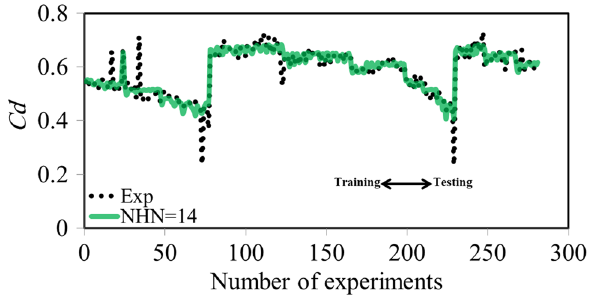
Fig. 5 Comparison of simulated coefficient of discharge with experi- mental data for NHLN equal to 14 in both training and testing